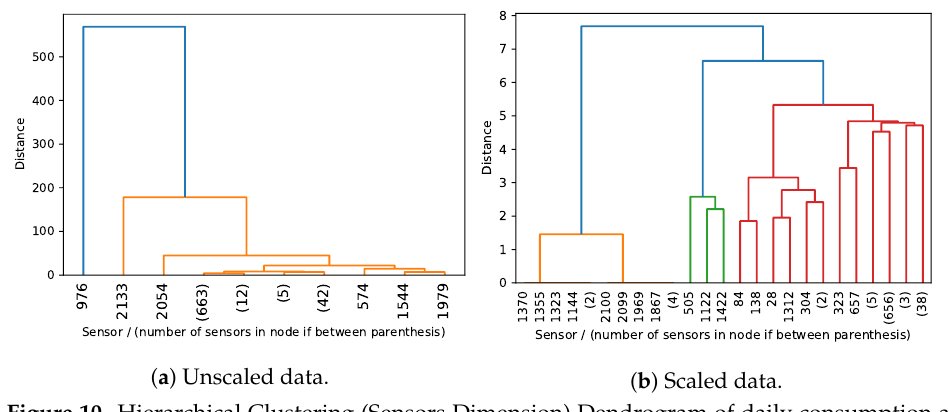
Figure 10. Hierarchical Clustering (Sensors Dimension) Dendrogram of daily consumption at In- fraQuinta,